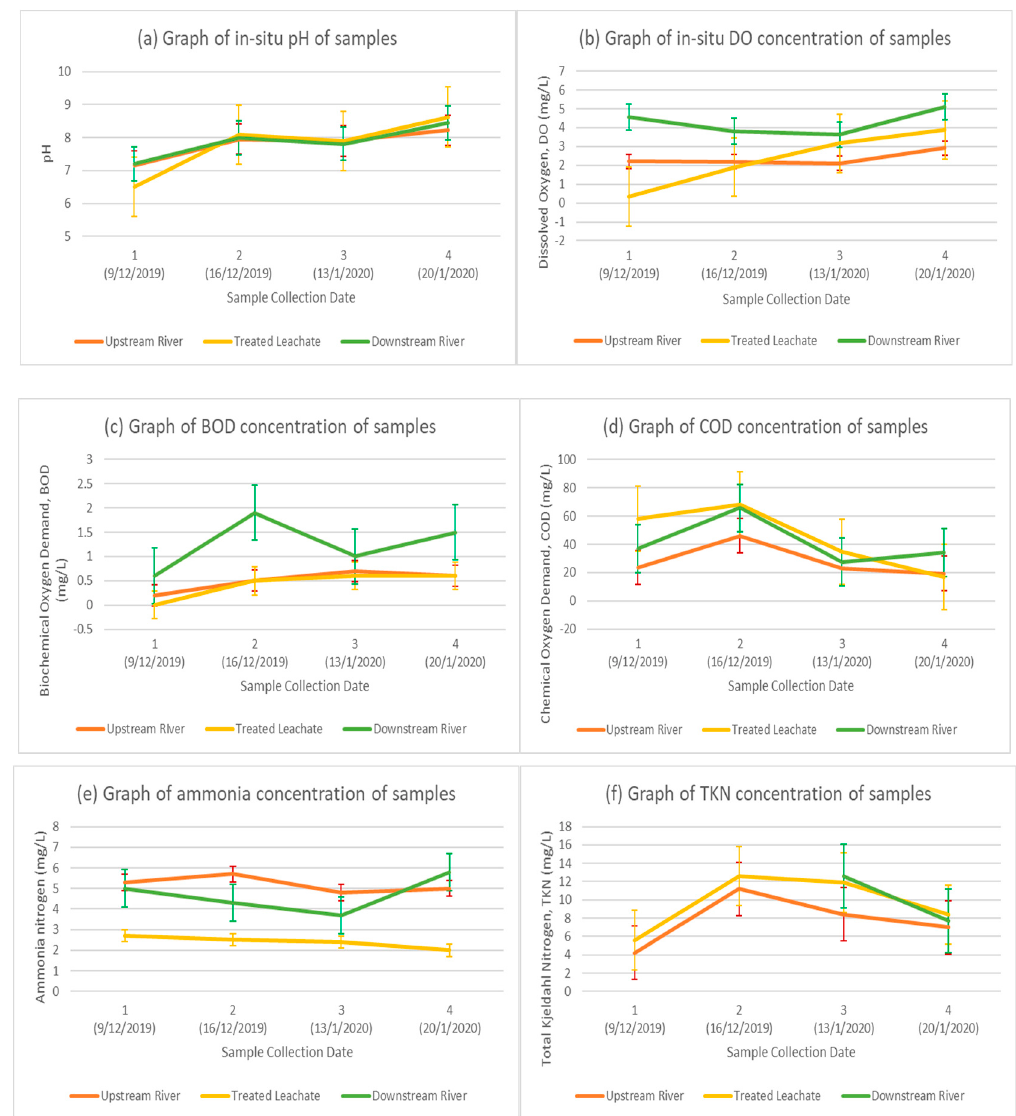
Figure 9. Graph of concentration of sample ( a ) in-situ pH, ( b ) in-situ DO, ( c ) BOD, ( d ) COD, ( e ) ammonia